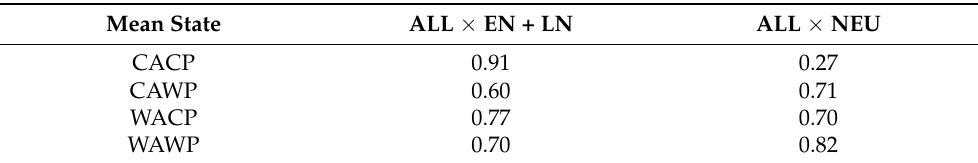
Table 3. Austral winter pattern correlations for PRP between ALL and EN + LN composites and between ALL and NEU composites in each mean